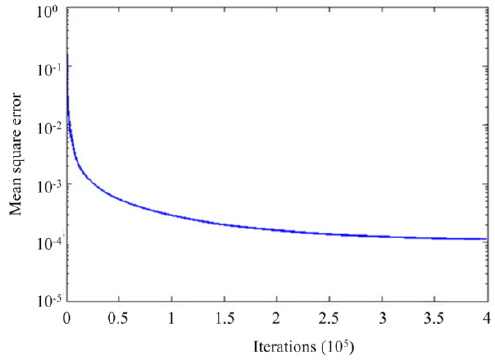
Figure 4. Training process of the network.